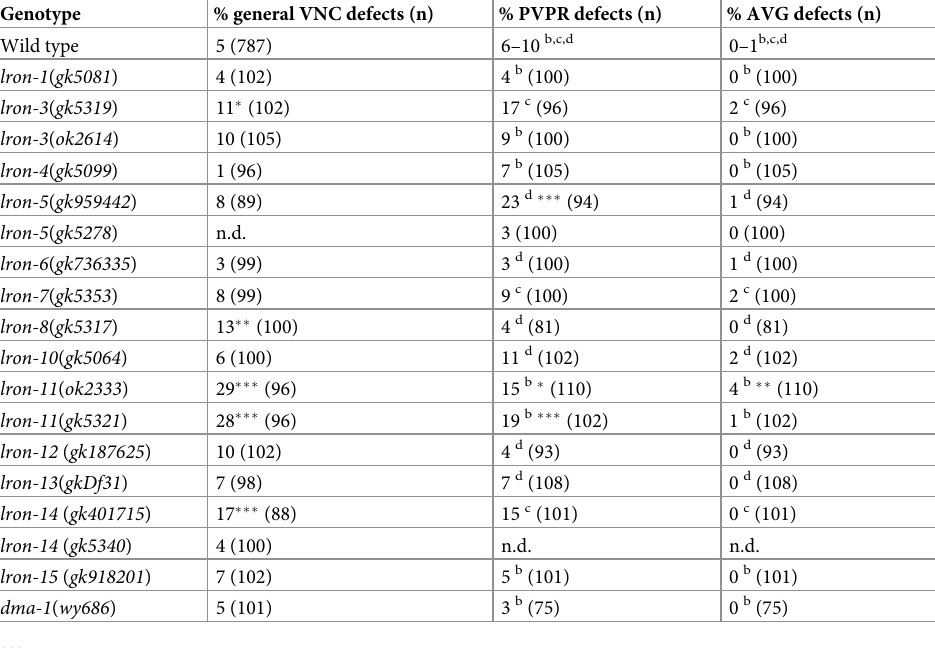
Table 1. VNC midline crossing defects of lron -mutants a .